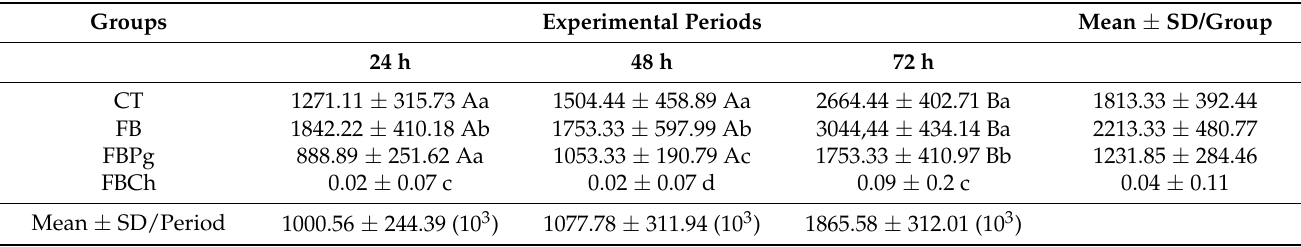
Table 2. Mean values of CFU/mL (10 3 ) ± standard deviations (SD) in computer-aided design and computer-aided manufacturing (CAD-CAM) resin.